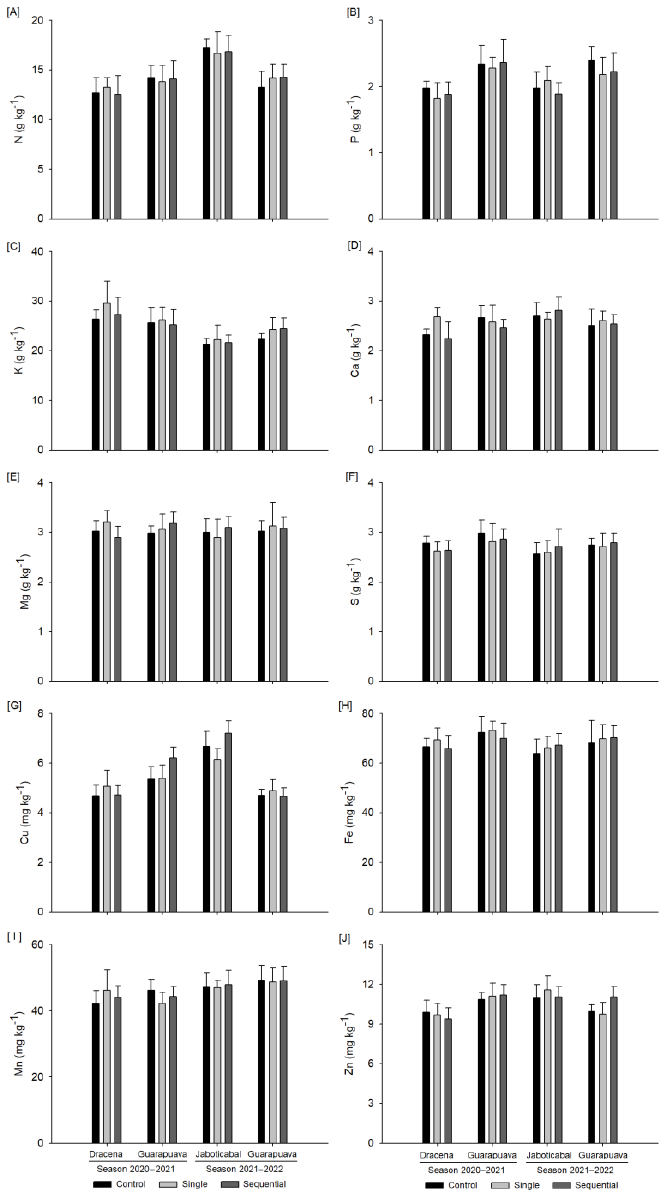
Figure 2. Content of macro-(N, P, K, Ca, Mg and S, respectively ( A – F )) and micronutrients (Cu, Fe, Mn and Zn, respectively ( G – J )) in leaf tissues of GR maize grown with no herbicide application (control), with a single application of glyphosate at 980 g of a.e. ha − 1 at stage V5 (single) and a sequential application of glyphosate at 520 + 980 g of a.e. ha − 1 at stage V3 and stage V7, respectively (sequential), in different locations and seasons. Error bars are one SE of the mean from ten